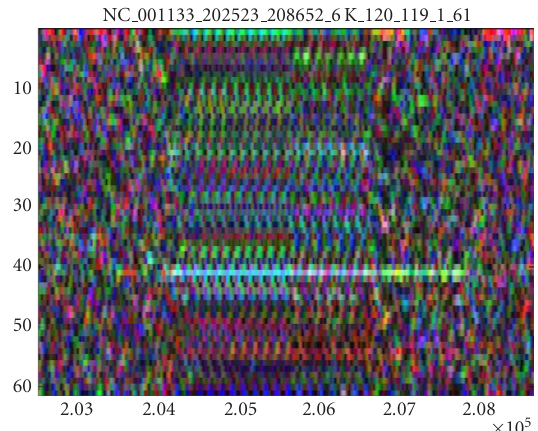
Figure 18: Spectrogram showing the quilt in protein FLO1 corre- sponding to the flocculin domain.